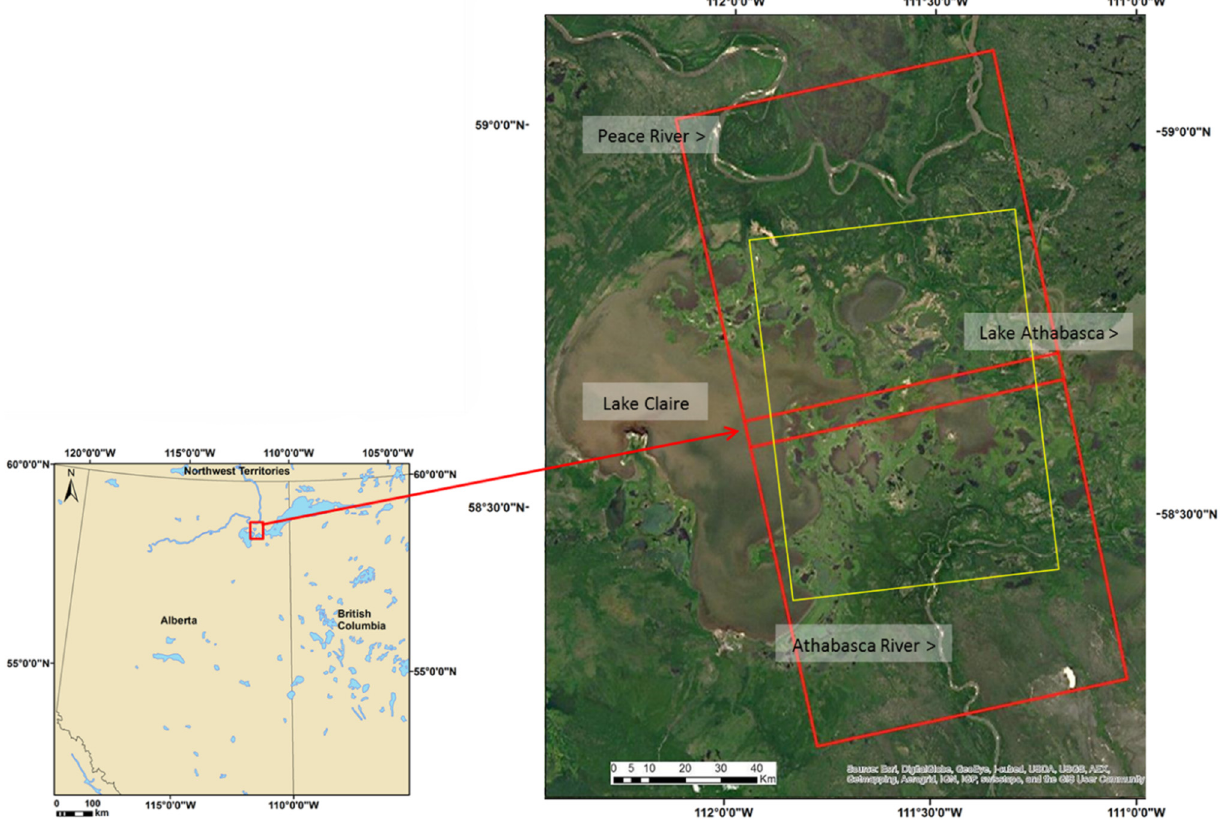
Figure 3. Peace-Athabasca Delta. RADARSAT-2 Ultra-Fine (U2W2) beam acquisition footprint for 2012 (red) and extent of cropped radar-derived surface water product